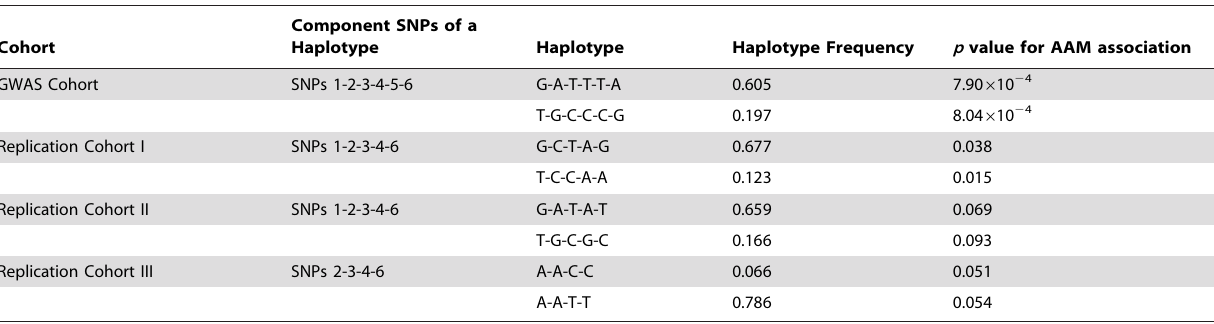
Table 5. Association analysis of haplotypes formed by SNPs of the SPOCK gene.